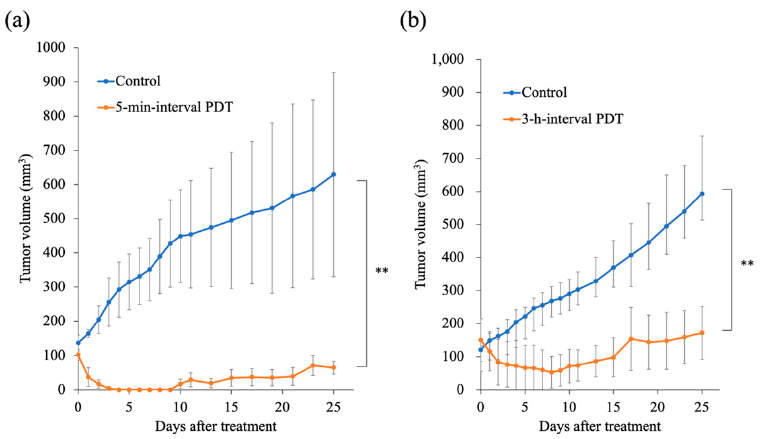
Figure 12. Changes in tumor volume in response to photodynamic therapy (PDT). ( a ) The 5-min-interval PDT ( n = 4). ( b ) The 3-h-interval PDT ( n = 3). Data were analyzed using Bonferroni’s multiple comparison test. The results are presented as the mean ± standard deviation. Data were analyzed using Bonferroni’s multiple comparison test (** p < 0.01).